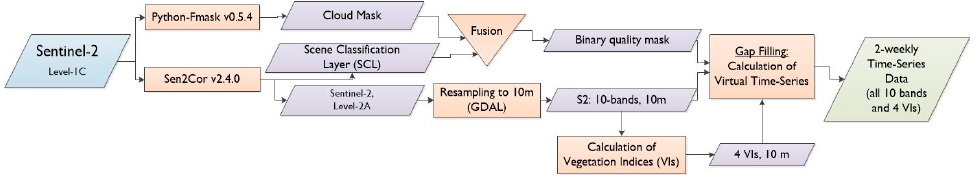
Figure 3. Sentinel-2 data pre-processing and feature generation.